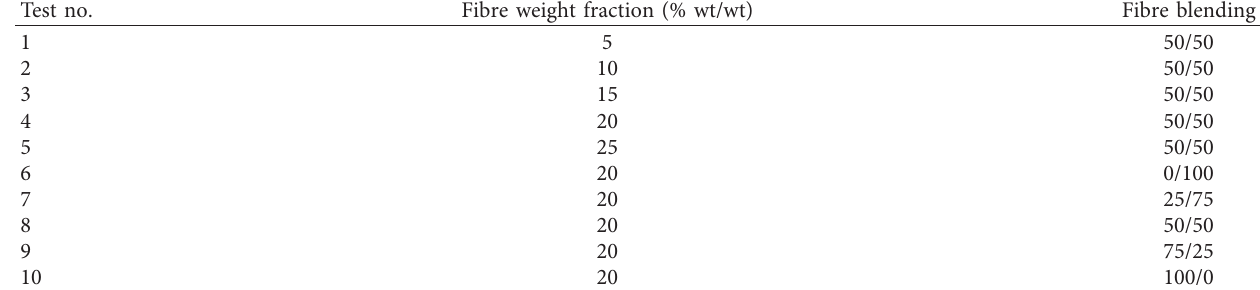
Table 1: Experimental design for fibre weight fraction and fibre blending (sisal/cattail). Test